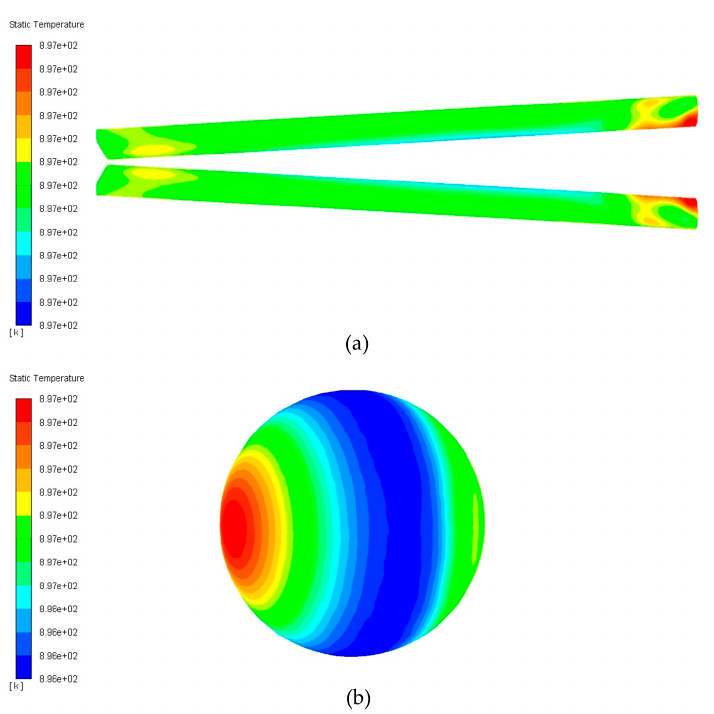
Figure 8. The temperature distributions of the ( a ) thermocouple wire and ( b ) solder ball are given separately.